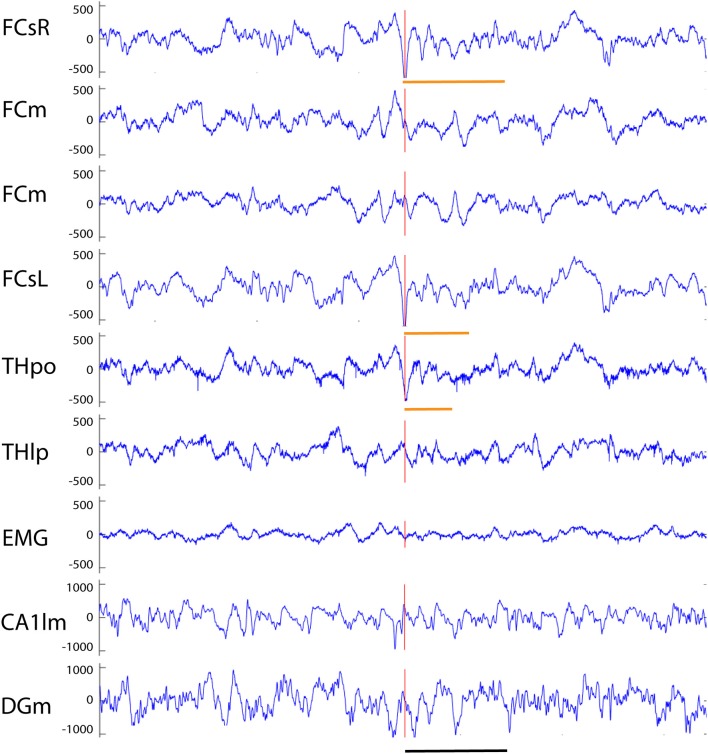
Example of a fast-spindle associated spike recorded from an APP/PS1 mouse. Both frontal screw channels and the thalamic THpo channel show a prominent surface-negative spike (red vertical line) that is followed by a 14 Hz spindle oscillation gradually fading off in amplitude (orange horizontal lines). On FCsR channels 7 cycles of oscillation can be identified, but only 3–4 on FCsL and THpo channels. Channel abbreviations as in Figure 2, except THpo, thalamus, posterior oralis nucleus; CA1lm, CA1 stratum lacunosum moleculare; DGm, dentate gyrus, stratum moleculare. Scale bar = 500 ms.